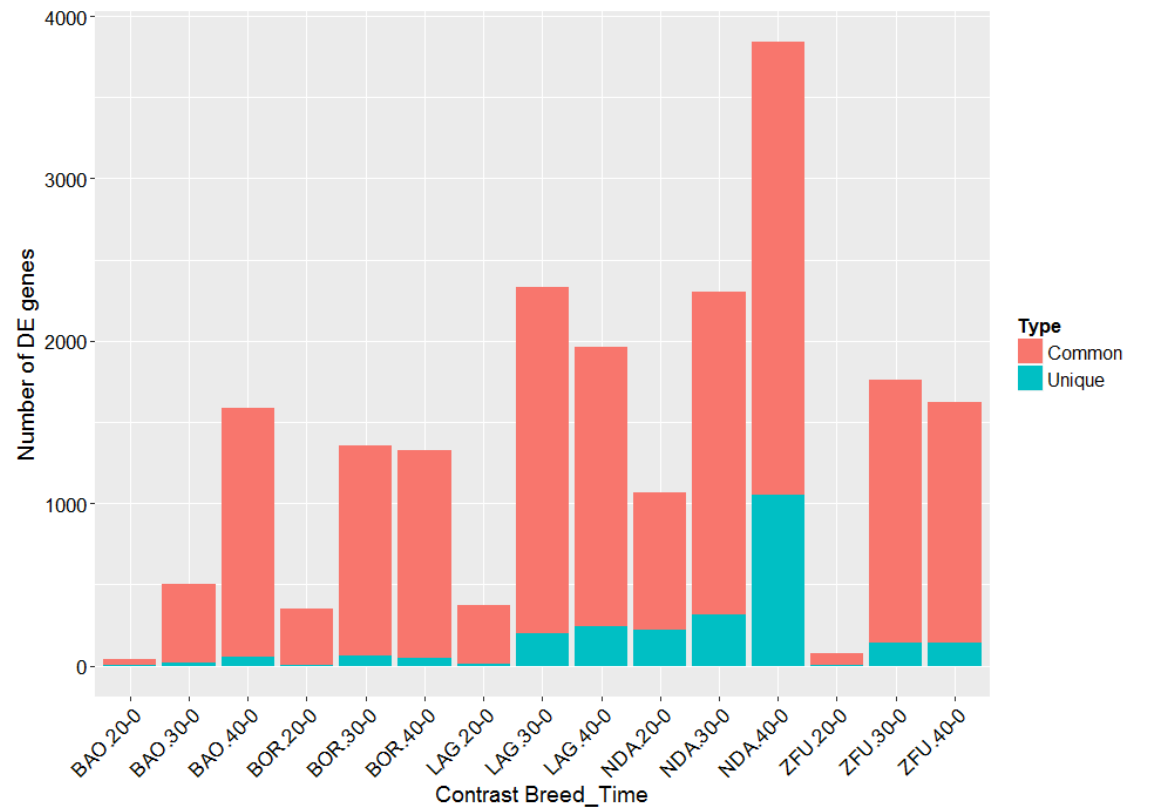
Figure 3 - Numbers of genes identified as differentially expressed in the 15 within-breed contrasts. The x-axis represents the 15 contrasts ordered by breed respectively BAO, BOR, LAG, NDA and ZFU, and for each breed, three contrasts according to days post-infection in comparison with before infection, respectively DPI.20-0, 30-0, 40-0. The y-axis represents the number of differentially expressed genes at the threshold of FDR<0.001. The red color corresponds to the part of genes that are differentially expressed and common to, at least, two breeds whatever the sampling time point; the blue color corresponds to the part of genes that are differentially expressed uniquely within a